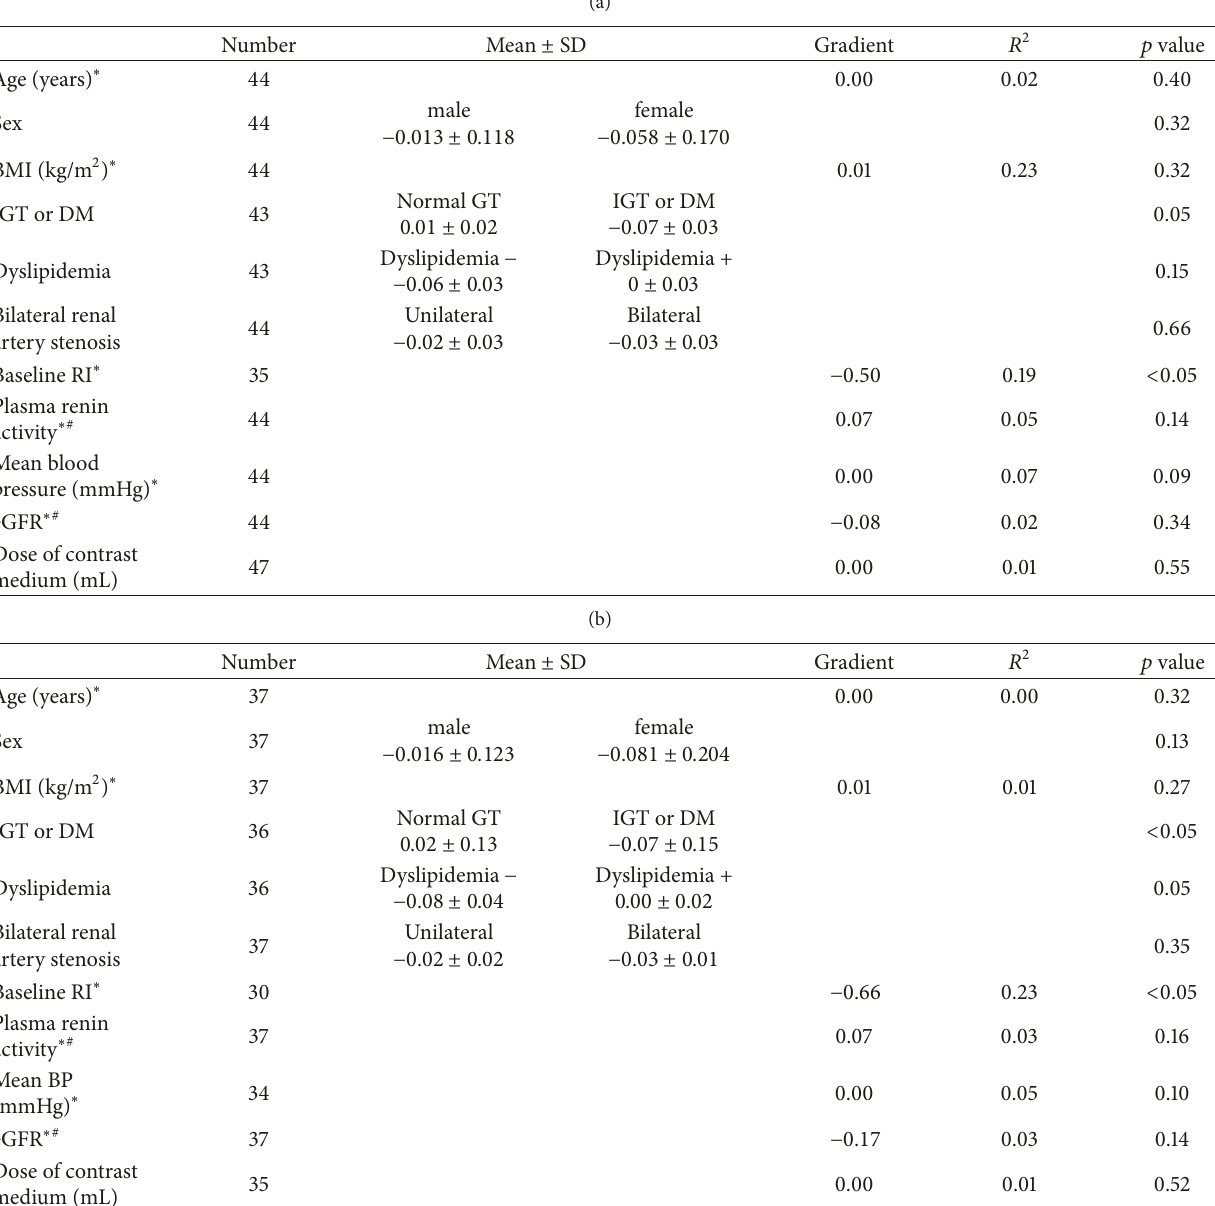
Table 3: Univariate analysis of predictive and confounding factors for regression of eGFR. A: all subjects; B: atherosclerotic RAS only; BP: blood pressure; BMI: body mass index; IGT: impaired glucose tolerance; DM: diabetes mellitus; RI: resistive index; eGFR: estimated glomerular filtration rate. Regression of eGFR was calculated as log(eGFR y1) − log(eGFR y0). ∗ Linear regression analysis, other